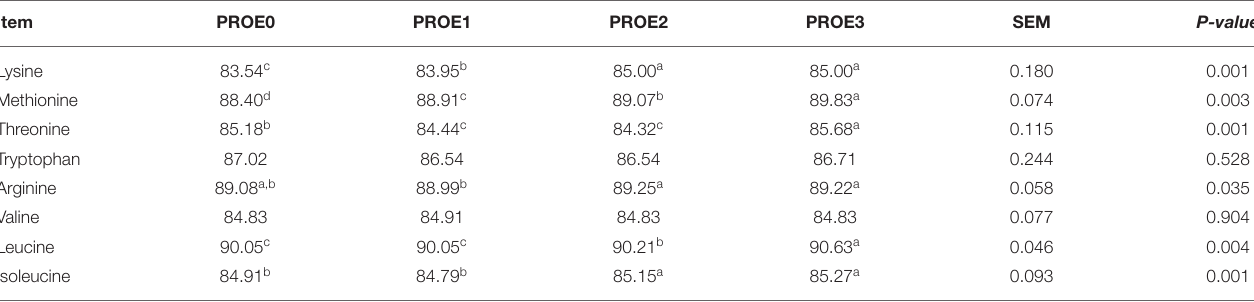
TABLE 5 | The effect of PROE supplementation on the apparent ileal digestibility coefficient (AID%) of amino acids. Item